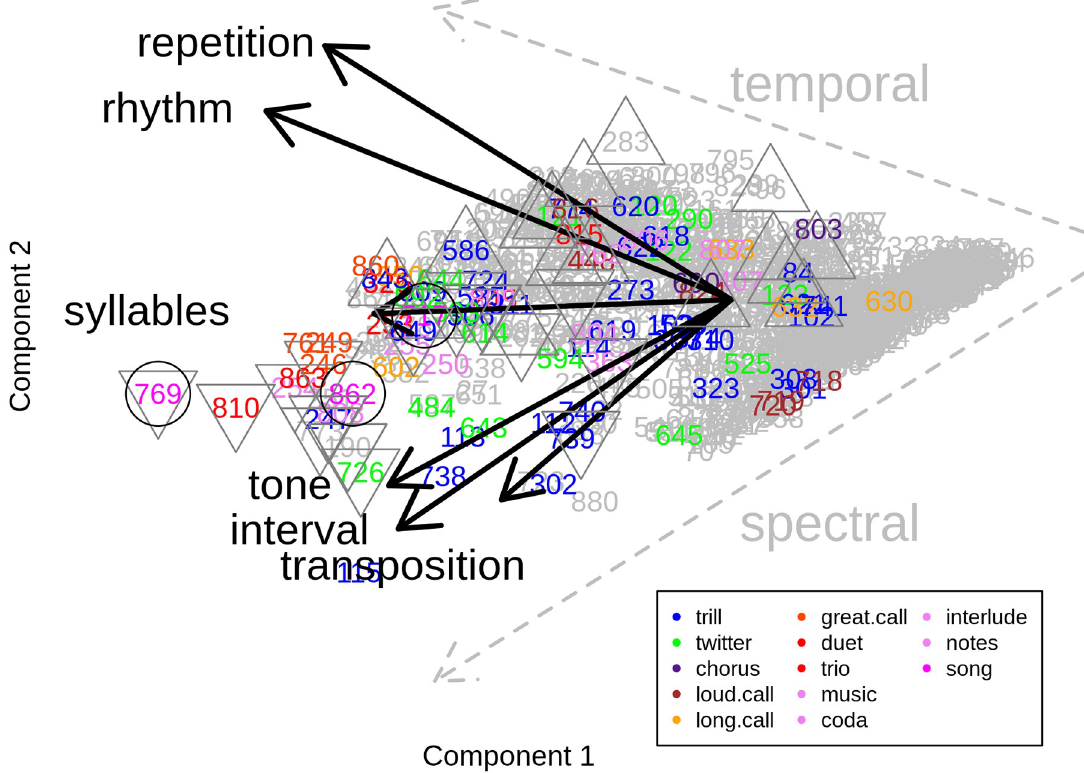
Fig 3. Principal components analysis [PCA] on six acoustic music universals (tone, interval, rhythm, repetition, transposition, and syllable count) where each numbered point above represents one of 832 unique primate vocalizations. Primary study author determined call types show affiliations amongst color-coded call number labels of music-like calls—as distributed across the primary dimensions (first two principal components [PC]) of this multivariate analysis. PC1 suggests that the most musical calls (far left) are distinctly more signal-rich than the long calls, loud calls, or choruses (right). Circled numbers represent the three example calls named as “songs.” The large group of gray numbers, just above and parallel to “spectral” (lower right), are all single unit calls. A second, less populated, region of non-musical calls, just below and parallel to “temporal” (upper right), reveals more periodic and repetitive calls. Each of the six arrow-head coordinates represents the loadings (or correlative contributions) of each of these structural acoustic feature scores along PC1 and PC2 (also see Fig 4). The three distinct clusters indicated by these PC loading coordinates (black arrow-heads), suggest a possible reduction in dimensionality down to just three proxy measures–a diversity measure: syllable count (left) and two redundancy measures: temporal (top) and spectral (bottom). This importance of syllable count and temporal or frequency redundancy is echoed by the avian song [69] and human music universals [6, 86] literature respectively. Downward pointing triangles around call numbers represent vocalizations with a high ARDI to SCI ratio, indicative of a more transpositional musicality (see Fig 1). Upward pointing triangles represent vocalizations with low ratios, indicating long and repetitive calls.